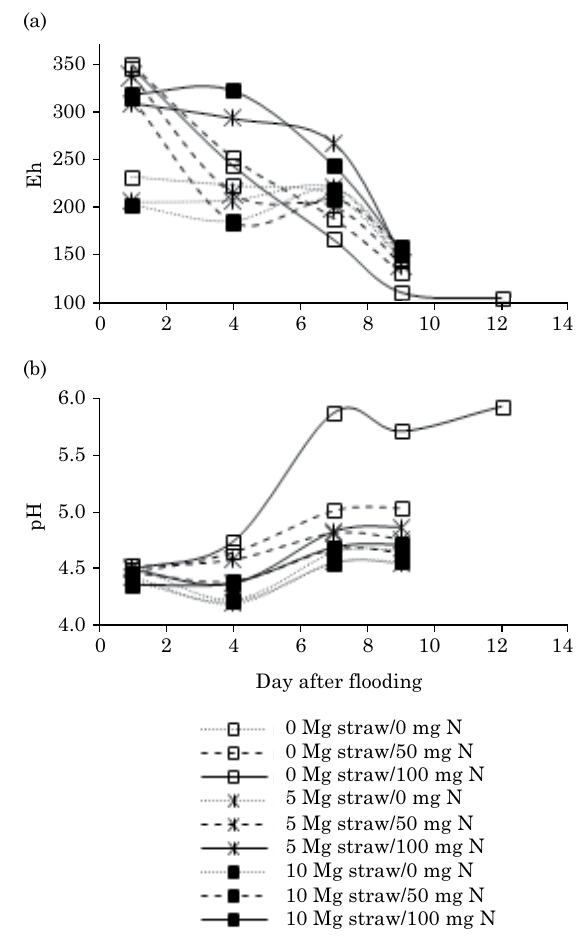
Figure 4. Values of redox potential - Eh (a) and pH (b) in flooded soils in pots under different amounts of rice straw and rates of NO − 3